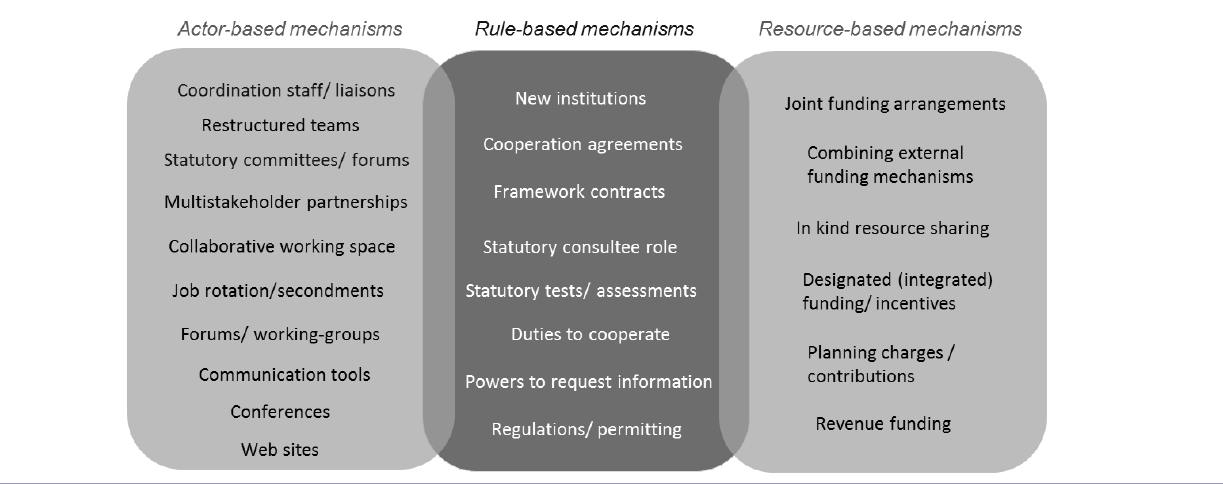
Fig. 3 . Overview of actor-, rule-, and resource-based